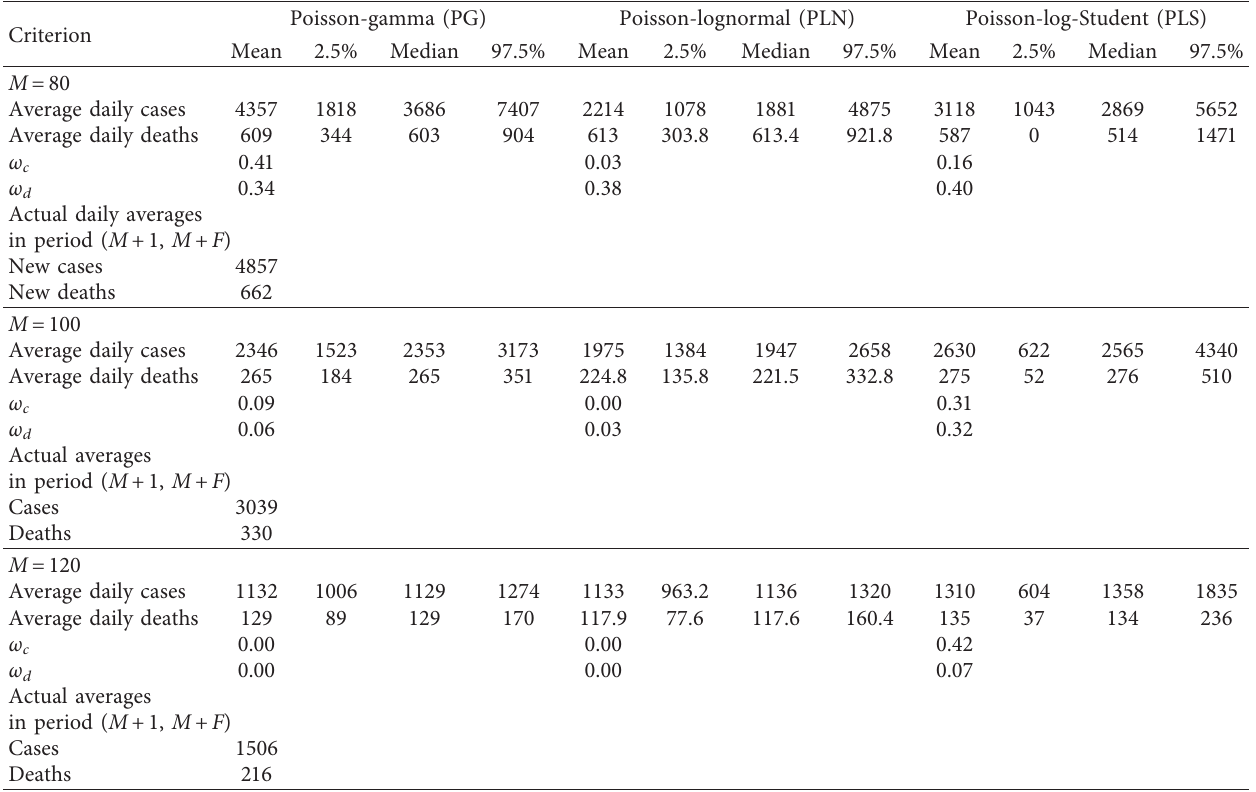
Table 3: Criteria for out-sample predictions ( M is number of days in training sample; F � 20 in all cases).